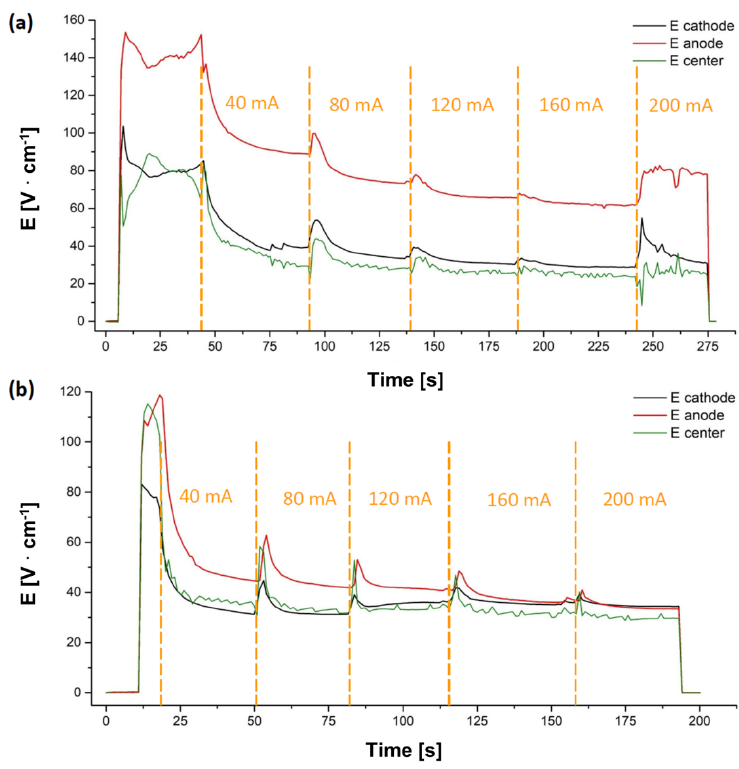
Figure 7. ( a ) Electrical field measured, during DC (ΔV lim = 160 V) FS experiment, at the anodic, cathodic and central region along the gauge length for different current limits in “bad contact” and ( b ) “good contact” configuration. The experiments were carried out in air using polycrystalline sample (cross section = 5 mm 2 ). Materials 2018 , 11 , x FOR PEER REVIEW